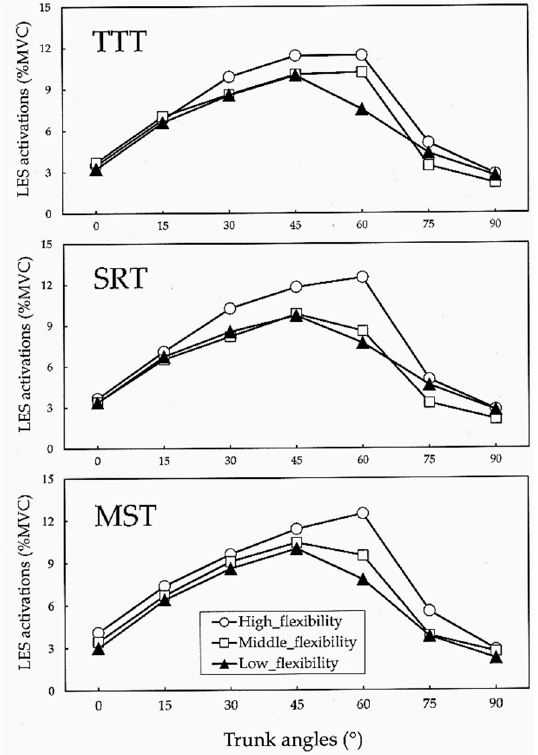
Figure 5. LES EMG alterations at varying trunk flexions for three flexibility grouping methods (%MVC, percentage of MVC data).